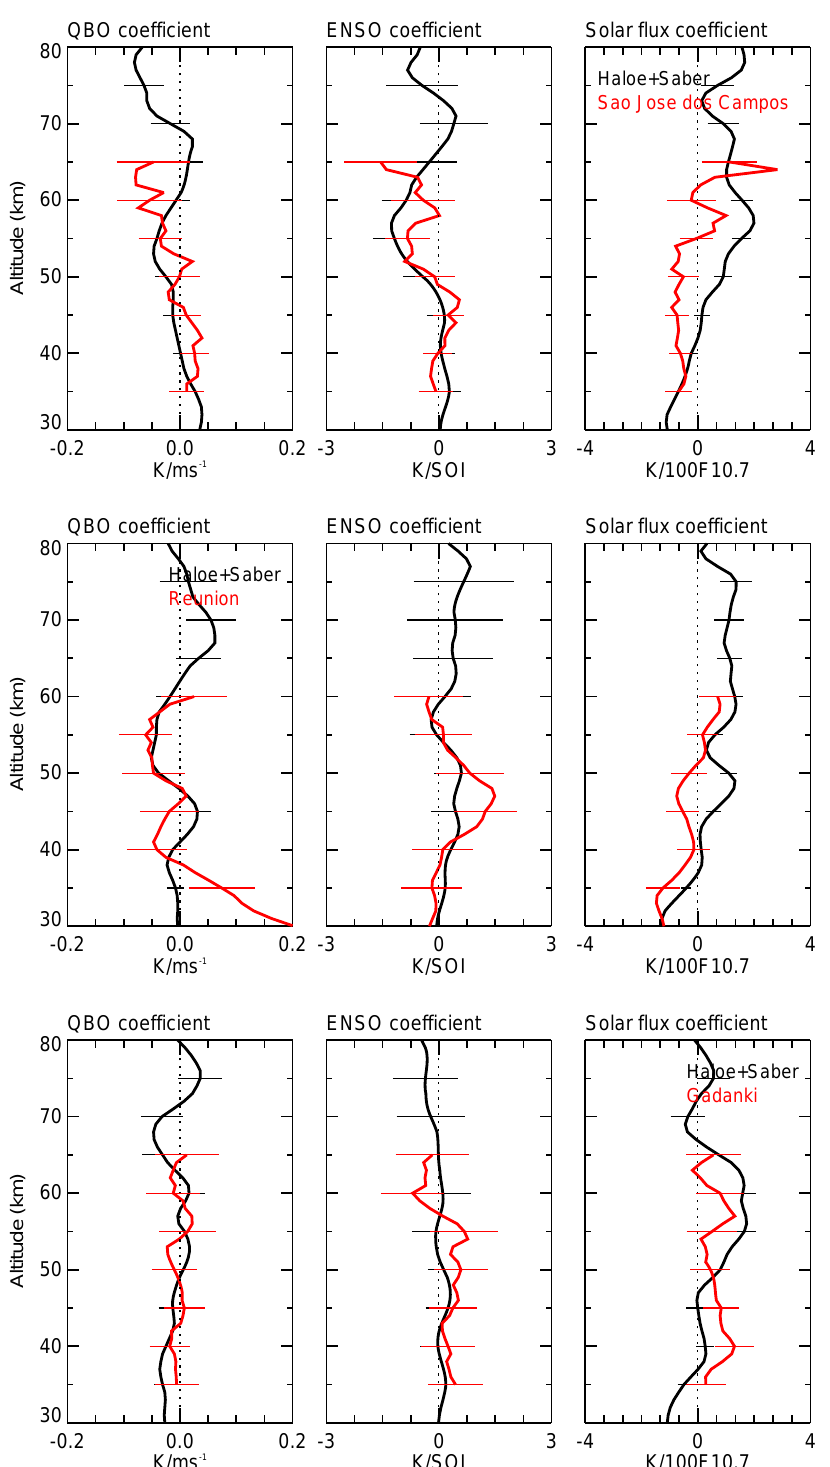
Fig. 9. Coefficients observed in QBO (left panels), ENSO (middle panels) and Solar (right panels) using combined measurements of HALOE and SABER over São José dos Campos (top panels), Reunion (middle panels) and Gadanki (bottom panels) locations. Coefficients observed using respective Lidars at different locations are also